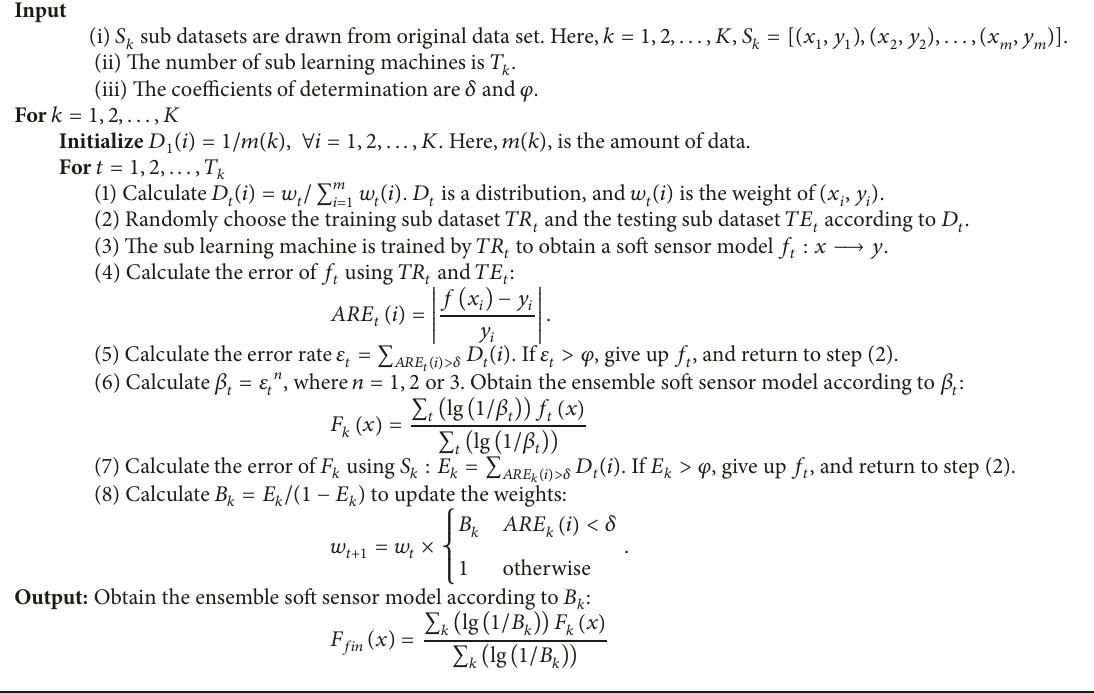
Algorithm 1: Incremental learning ensemble